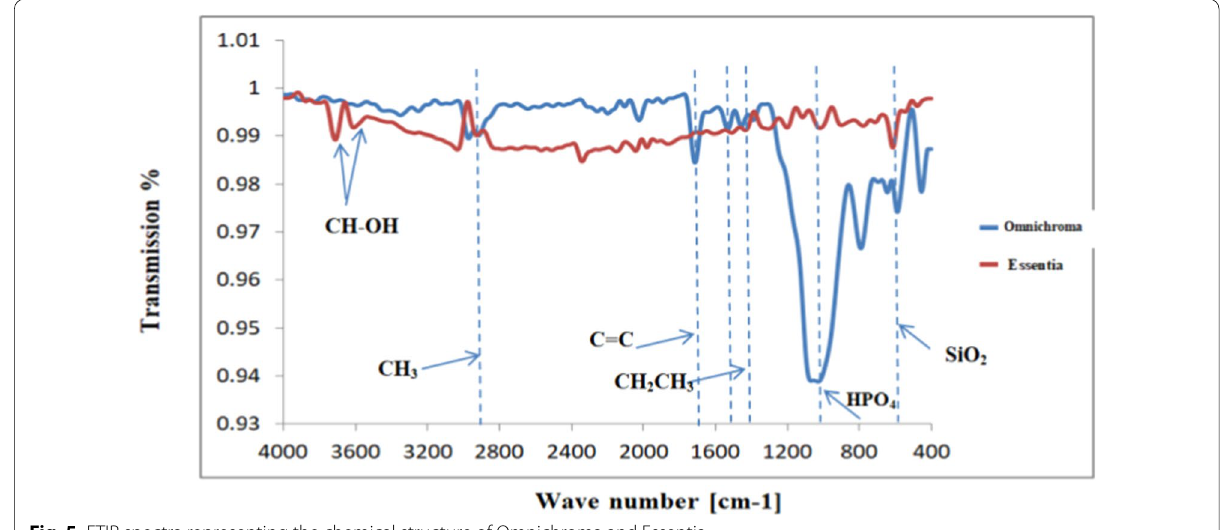
Fig. 5 FTIR spectra representing the chemical structure of Omnichroma and Essentia